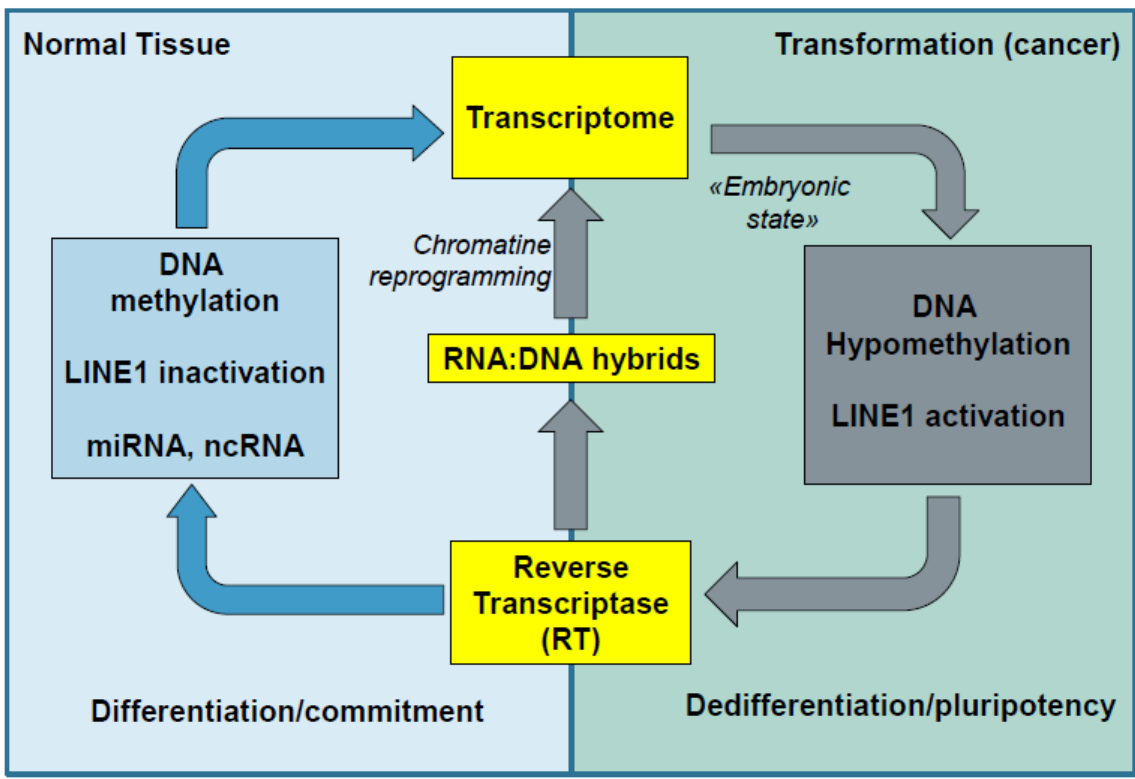
Figure 5. Model scheme of LINE1 working mode in normal cells and during malignant transformation. (Adapted from Sciamanna et al. [3]).